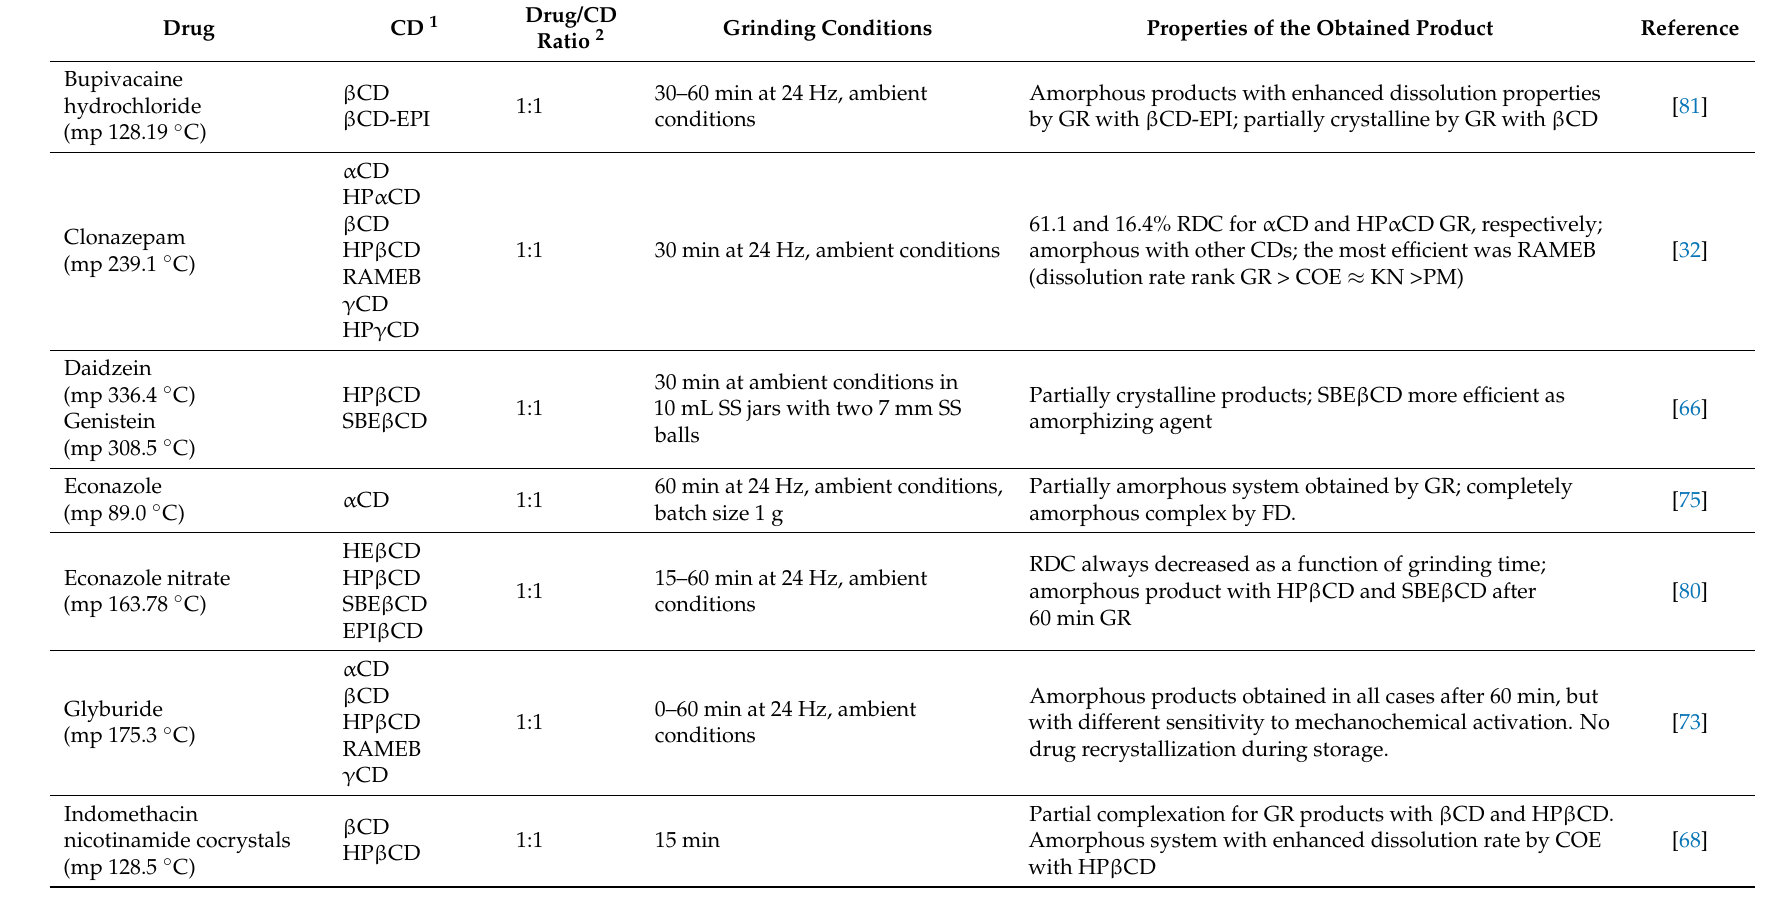
Table 2. An overview of binary drug/CD complexes prepared by grinding using high energy vibrational